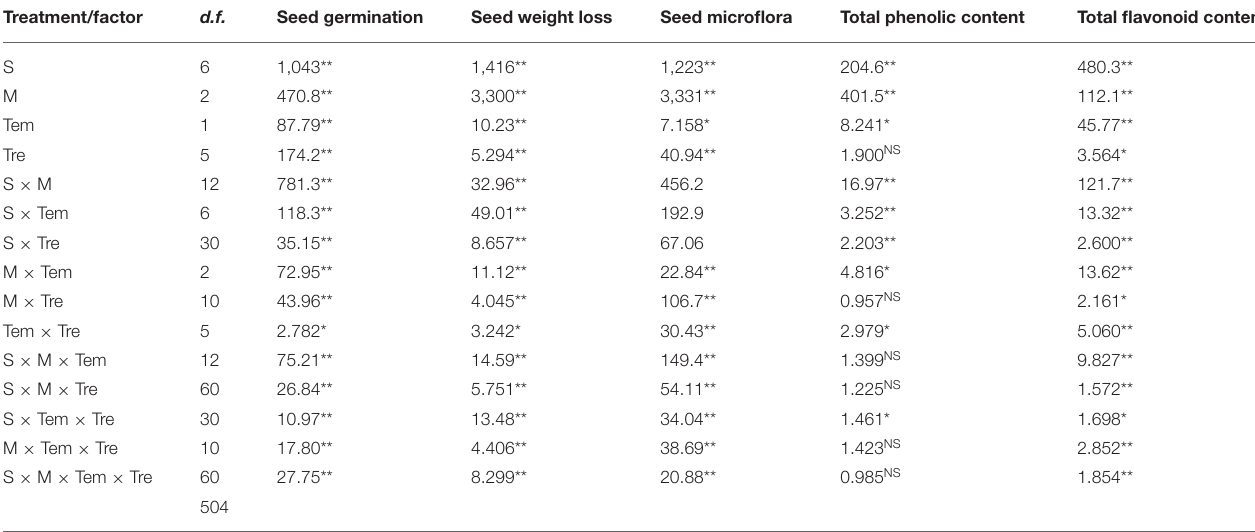
TABLE 2 | Summary of MANOVA for various parameters; seed germination (%), seed weight loss (%), seed microflora (%), total phenolic content (ppm dry weight gm − 1 ), total flavonoid content (ppm dry weight gm − 1 ) for seeds of seven medicinal species with factors species (S), month (M), temperature (Tem), treatment (Tre).